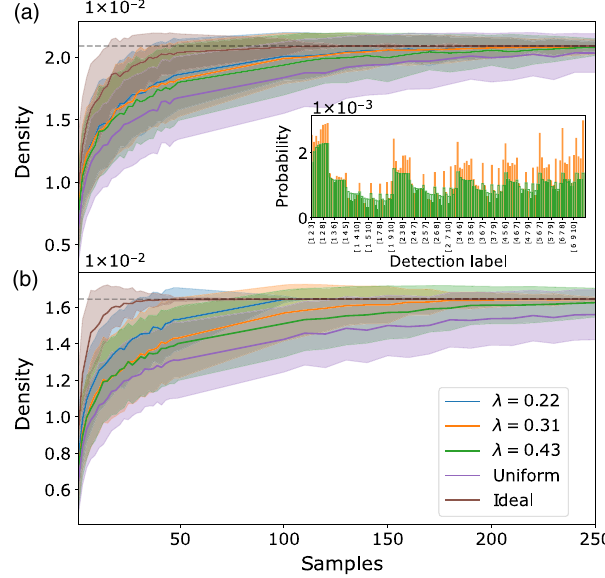
FIG. 6. (a) Mean density of the three-node subgraph as a function of the number of samples drawn. The inset shows the probability distribution for the nondegenerate output states of the experimental samples (orange filling) and the theoretical model (green edge). (b) Mean density of the four-node subgraph as a function of the number of samples drawn. The purple line indicates a uniform random search, the blue, orange, and green lines use samples obtained from the GBS experiment for different values of the squeezing as indicated in the legend, and the brown line indicates samples obtained when sampling from the distri- bution obtained from j Haf ð B n Þj 2 . The dashed line indicates the density of the densest subgraph. The search speed decreases when increasing the squeezing. This effect is further studied in Sec. V.